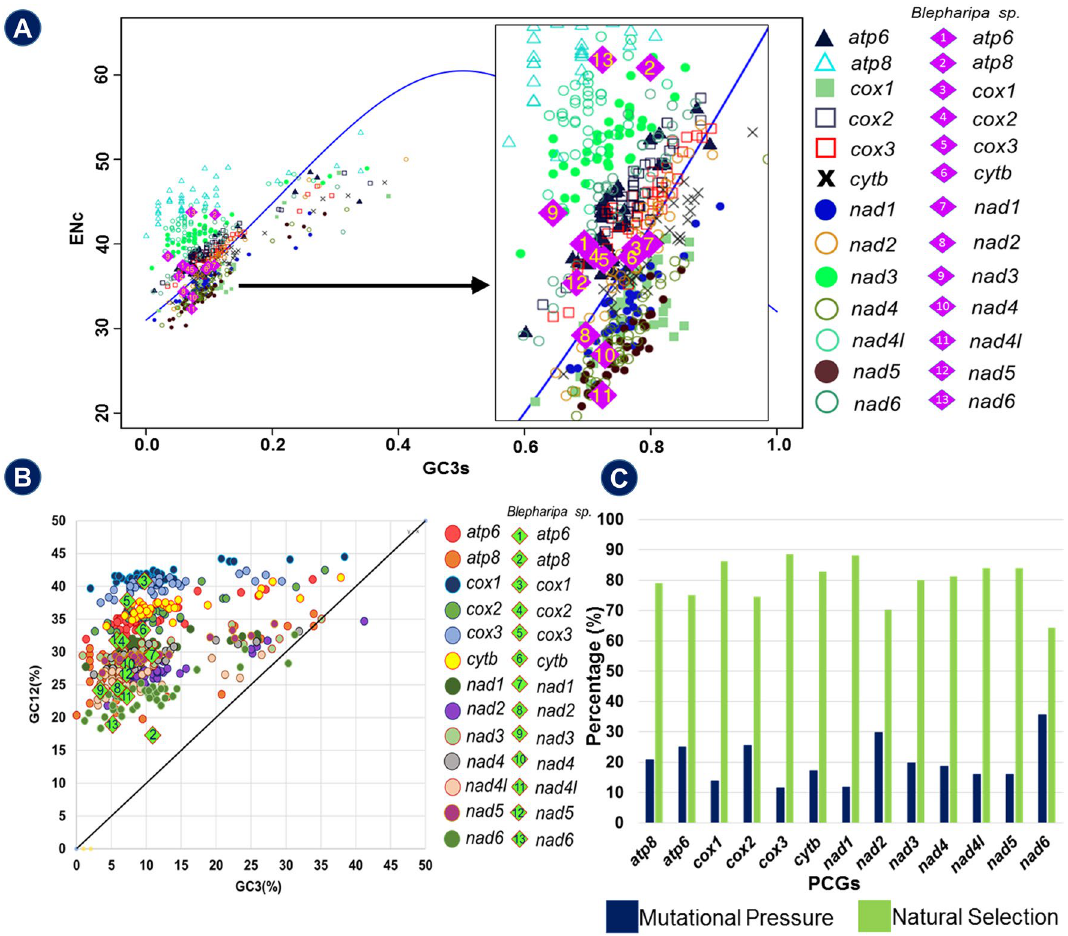
Figure 7. ( A ) The ENc vs. GC3s plots of Oestroidean mitochondrial protein-coding genes. The standard curve ENc = 2 + GC3s + 29/[GC3s2 + (1 − GC3s)2] represents the expected ENc to GC3s. ( B ) Neutrality plots (GC12 vs. GC3) of 13 PCGs of 42 species. GC12 stands for the average value of GC content in the first and second position of the codons (GC1 and GC2). While GC3 refers to the GC content in the third codon position (each dot signifying a gene). ( C ) Probability of selection pressure on each PCGs of Oestroidea. The regression line of all PCGs denoted by y = mx + c (Where, Mutational Pressure (M) = m * 100, Natural Selection (N) = 100 −